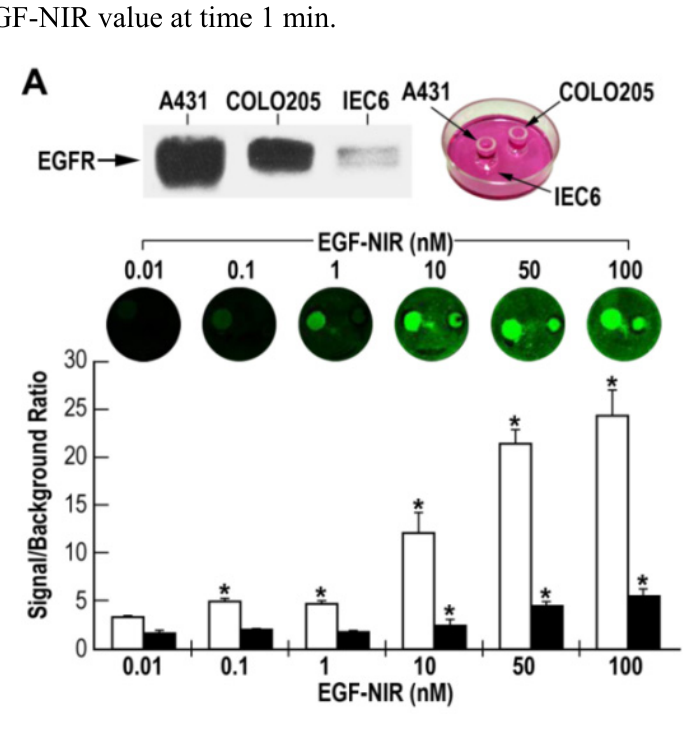
Figure 3. Saturation ( A ) and kinetics ( B ) of EGF-NIR binding to COLO205 CRC cells measured by NIR bio-imaging. Focal models of A431 (white bars) and COLO205 (black bars) cells were generated using the same plate, surrounded by IEC6 cells. The signal (CRC cell line) to background (IEC6) ratio was estimated at identical conditions for all cultures (mean ± SD, n = 9); The NIR imaging was estimated at the following conditions: resolution: 170–340 microns; pixel area: 0.03 mm 2 ; quality: medium-low; focus offset: 3; channels: 800 nm; intensity: 1; ( A ) The cultures were incubated for 20 min at 37 °C with different concentration of EGF-NIR; Significance: * p < 0.05 vs. EGF-NIR value of 0.01 nM; Inserts: NIR scans; Upper insert: level of EGFR measured by Western blotting and focal organization of the cells; ( B ) The cultures were incubated for different periods of time at 37 °C with 7 nM EGF-NIR; * p < 0.05 vs. scrambled or control; Significance: * p < 0.05 vs. EGF-NIR value at time 1